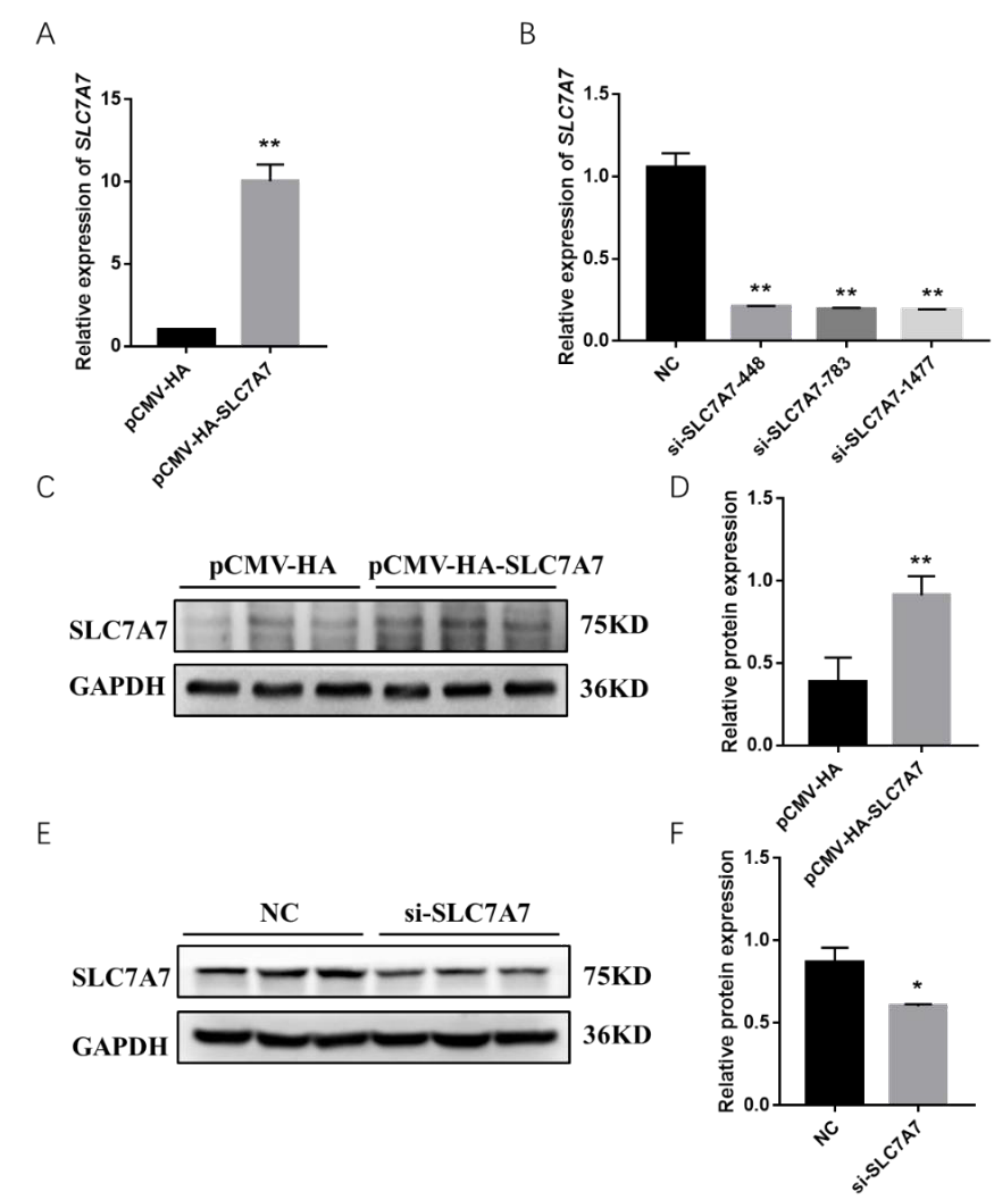
Figure 4. Expression level changes following overexpression and interference of SLC7A7 in PSCs. ( A ) The mRNA expression level of SLC7A7 after overexpression of SLC7A7 ; ( B ) the mRNA expression level of SLC7A7 after interference of SLC7A7 ; ( C ) protein expression level of SLC7A7 after overexpression of SLC7A7 ; ( D ) Quantification of Western blotting after overexpression of SLC7A7 ; ( E ) the protein expression level of SLC7A7 after interference of SLC7A7 ; ( F ) quantification of Western blotting after interference of SLC7A7 . *, ** indicate significant difference at p < 0.05 and p < 0.01, respectively.